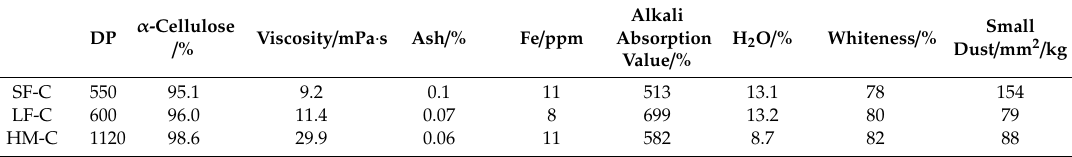
Table 1. Physical properties of cellulose with di ff erent degrees of polymerization (DPs). α -Cellulose / mPa · s Ash / % Fe / DP / % Viscosity